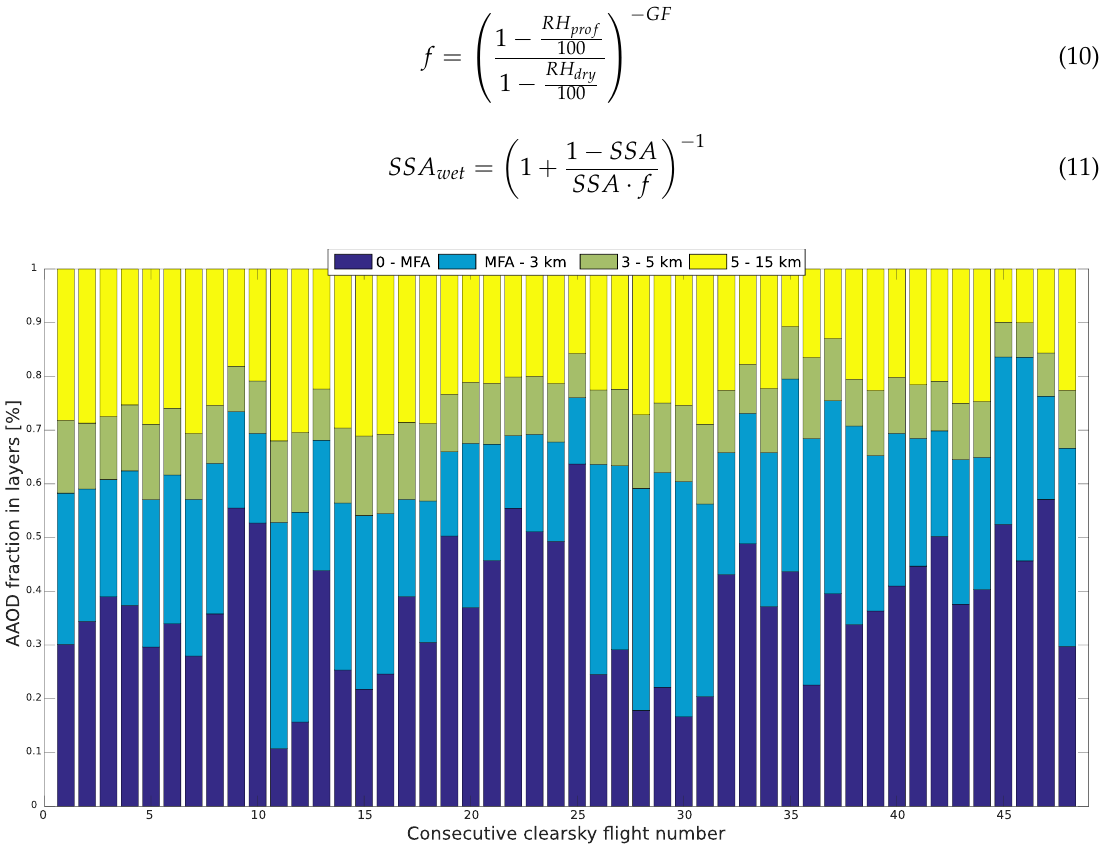
Figure 7. Fraction of absorbing aerosol optical depth (AAOD) in layers. Estimation based on unmanned aerial system (UAS) measurements scaled with lidar derived extinction and measured SSA. Profiles acquired during June–August 2015 at SolarAOT site. MFA—maximum flight altitude of